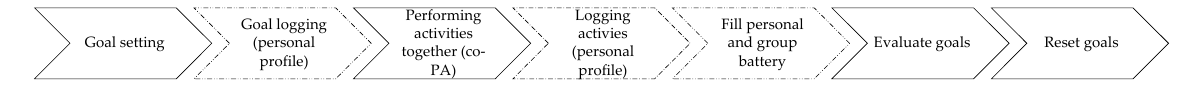
Figure 3. Graphical representation of goal setting and logging process on the profile on the website.